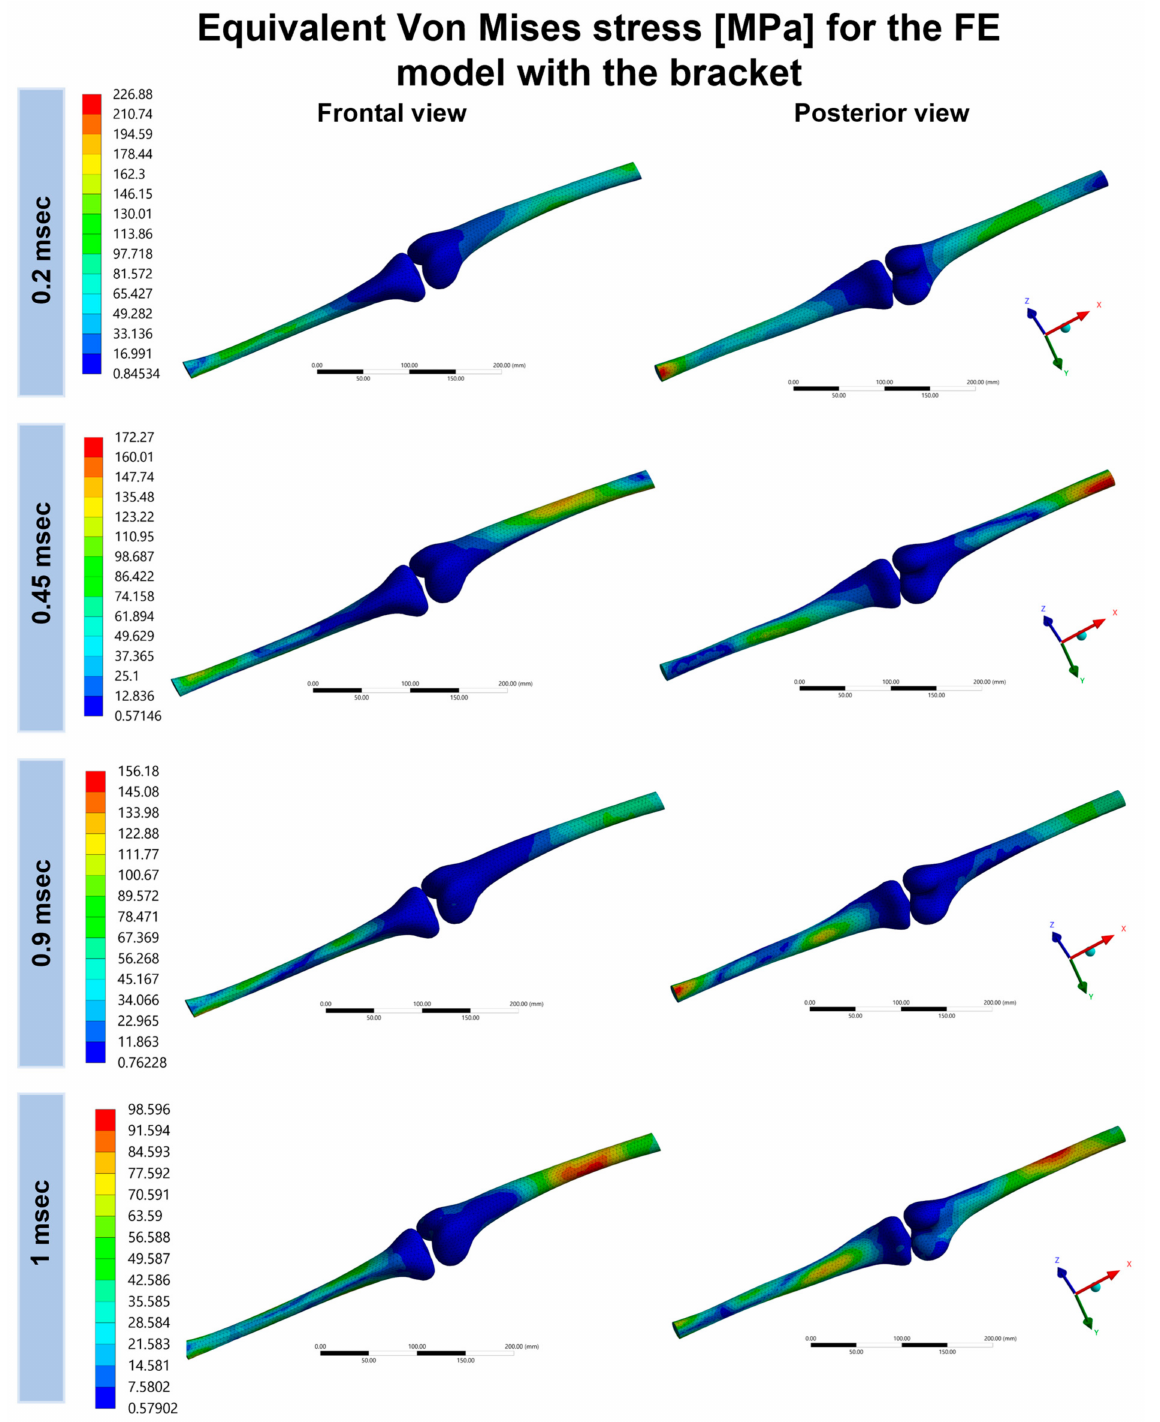
Figure 8. Equivalent Von Mises stress distribution in the bone component of the limb for the FE model with